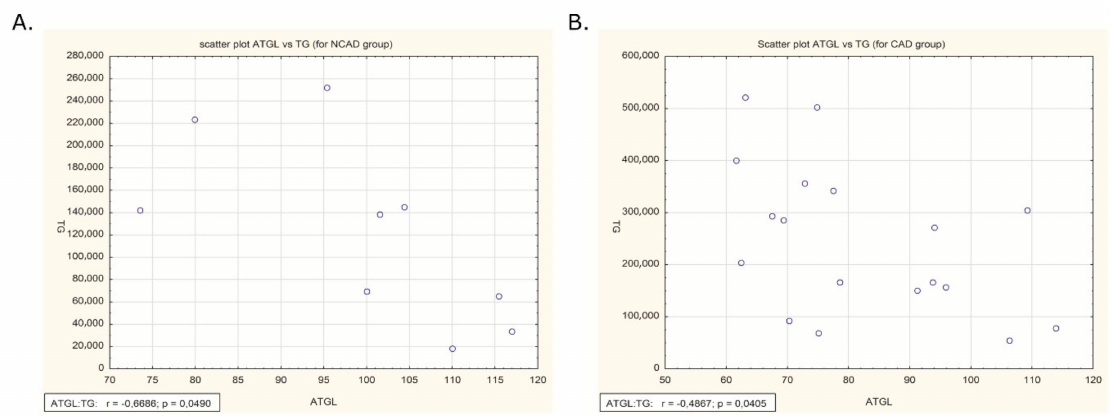
Figure 10. Correlations of ATGL expression and TG content in human myocardium of ( A ) NCAD and ( B ) CAD